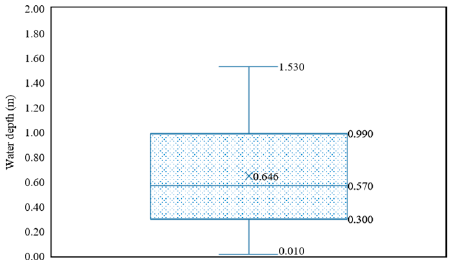
Figure 5. Data distribution of water depth survey samples ( n = 171).